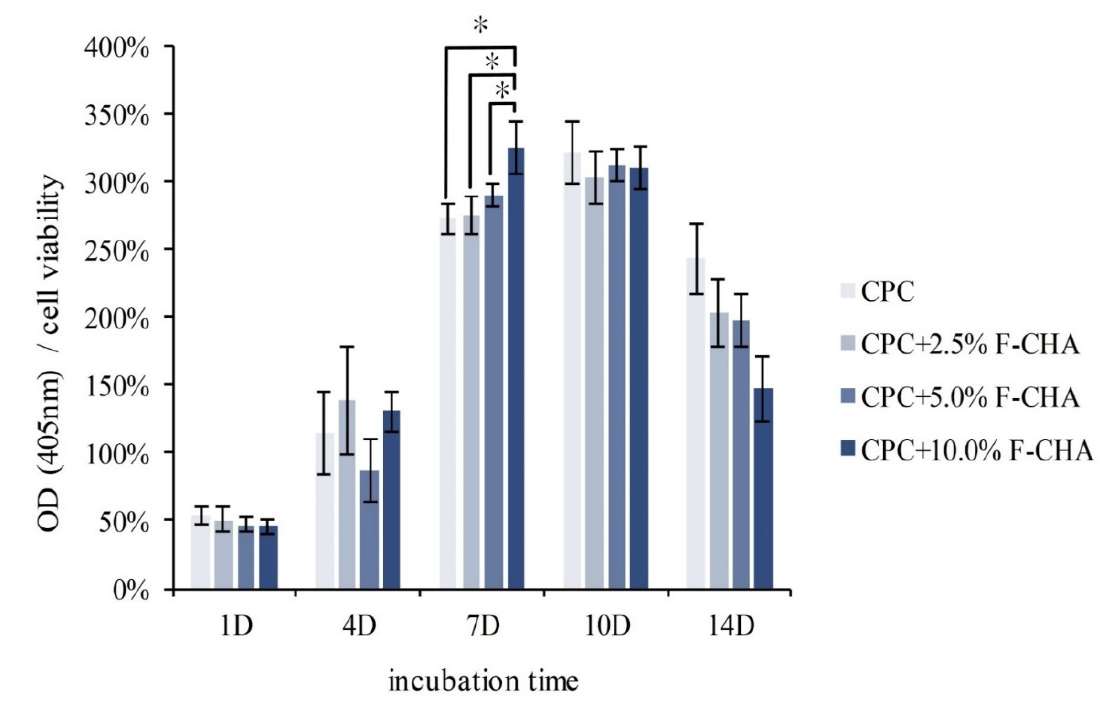
Figure 12. Semi-quantitative ALP activity of D1 cells seeded on CPC composites with different ratios of ferulic acid-carbonated apatite nanorods (CPC + F-CHA, n = 6). Groups marked * indicate statistically significant differences ( p < 0.05).